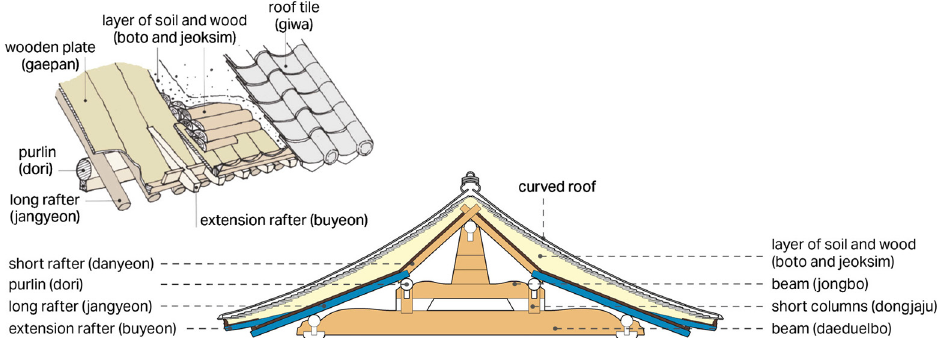
Figure 7. Two Beams and a Short Column ( Dongjaju ) with Diagonal Connecting Members/Two Rafter Types in a Different Inclination (Traditional Korean Heavy Timber Framing) Reprint with permission [16]; 2007, Dongnyok Publishers.